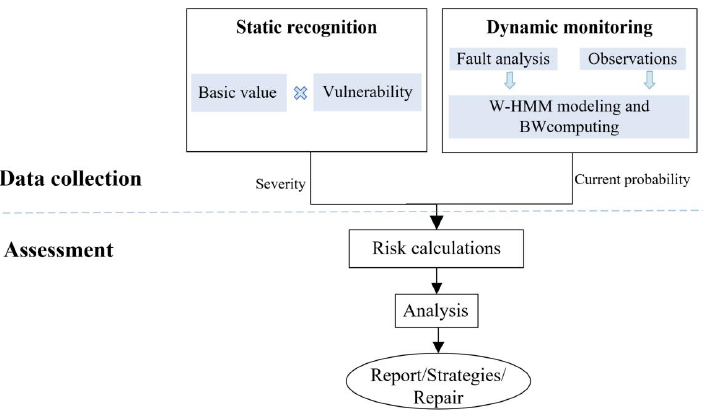
Figure 6. Security evaluation framework of